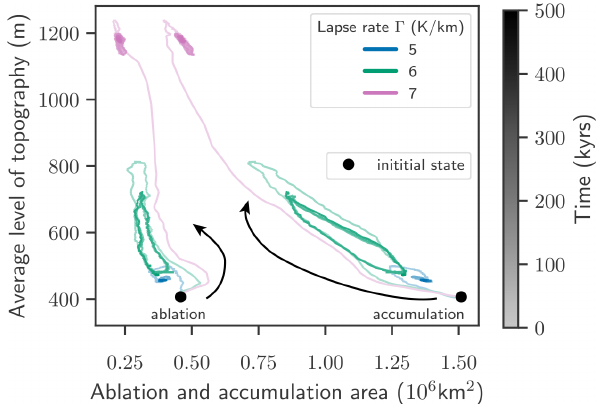
Figure 7. State space trajectories for different regimes for the three different lapse rates (cid:48) = [ 5 , 6 , 7 ] Kkm − 1 . The curves represent the average height of the bedrock topography vs. the ablation and the accumulation area. Blue: lapse rate (cid:48) = 5Kkm − 1 , incomplete re- covery of the ice volume. Green: lapse rate (cid:48) = 6Kkm − 1 , oscilla- tion of the ice volume. Purple: lapse rate (cid:48) = 7Kkm − 1 , irreversible loss of the ice volume. The color code corresponds to Fig. 2 a; that is the temperature forcing is (cid:49)T = 2K and the mantle viscosity is η = 1 × 10 21 Pas. The color shading represents time, as indicated by the color bar on the right side. The average bedrock and the ac- cumulation and ablation area of the initial state are represented by the black